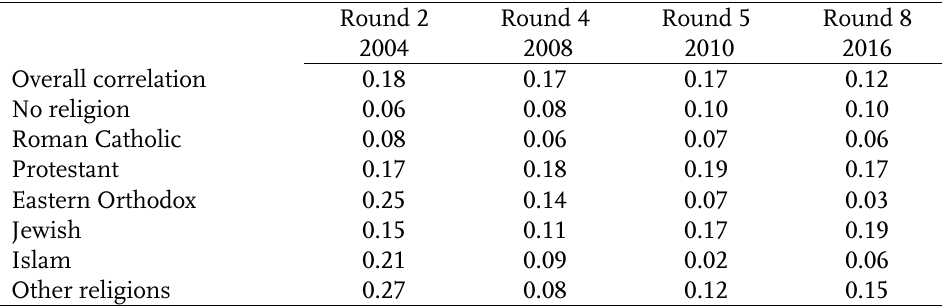
Round 2 Round 4 Round 5 2004 2008 2016